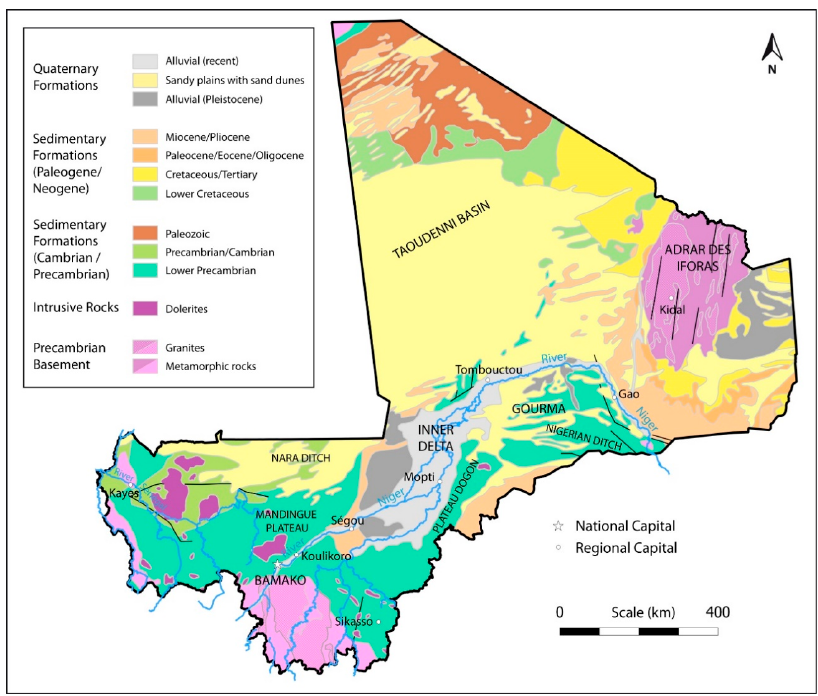
Figure 2. Main geological units of Mali (modified from Raase 2010 [29]). Table 1. Groundwater units of Mali (after Département de la Coopération Technique pour le Développement du Mali [26]). See Figure 3 for the spatial location of groundwater units.